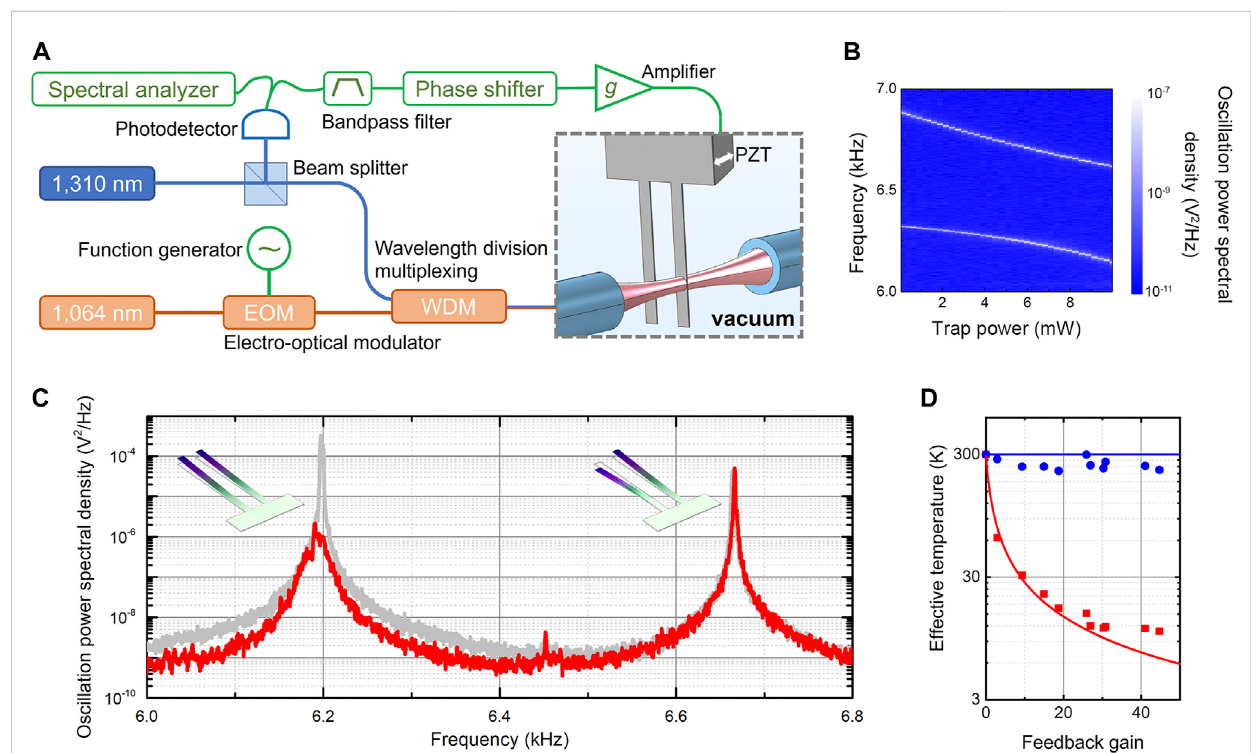
FIGURE 1 (A) Schematic illustration of the experimental setup. The power of the 1,310 nm probe is 0.12 mW. A bandpass fi lter with pass band from 1 kHz to 10 kHz is used to fi lter out the motion signal of higher-order mechanical modes. Also, the motion signal shifted by a phase of π /2 is ampli fi ed to drive a piezoelectric actuator that shakes the whole chip in the direction parallel to mechanical oscillation to apply the feedback force. The experiment is conducted in high vacuum at an ambient condition with temperature T 0 (cid:1) 300K. (B) Optical mediation of mode hybridization between the two elastically coupled cantilevers. (C) Thermal oscillation power spectral density of the elastically coupled cantilevers under the control of feedback. For comparison, the oscillation spectrum at feedback gain g (cid:1) 9 (red curve) is plotted with that at feedback gain g (cid:1) 0 (gray curve). Inset: the shapes of oscillation for the symmetric and the anti-symmetric modes. (D) Effective temperature of the two normal modes. The effective temperatures of the symmetric mode (red rectangles) and anti-symmetric mode (blue dots) are measured experimentally at different feedback gains. Also, the theoretical results for the symmetric mode (red line) and anti-symmetric mode (blue line) are calculated at the same condition of our